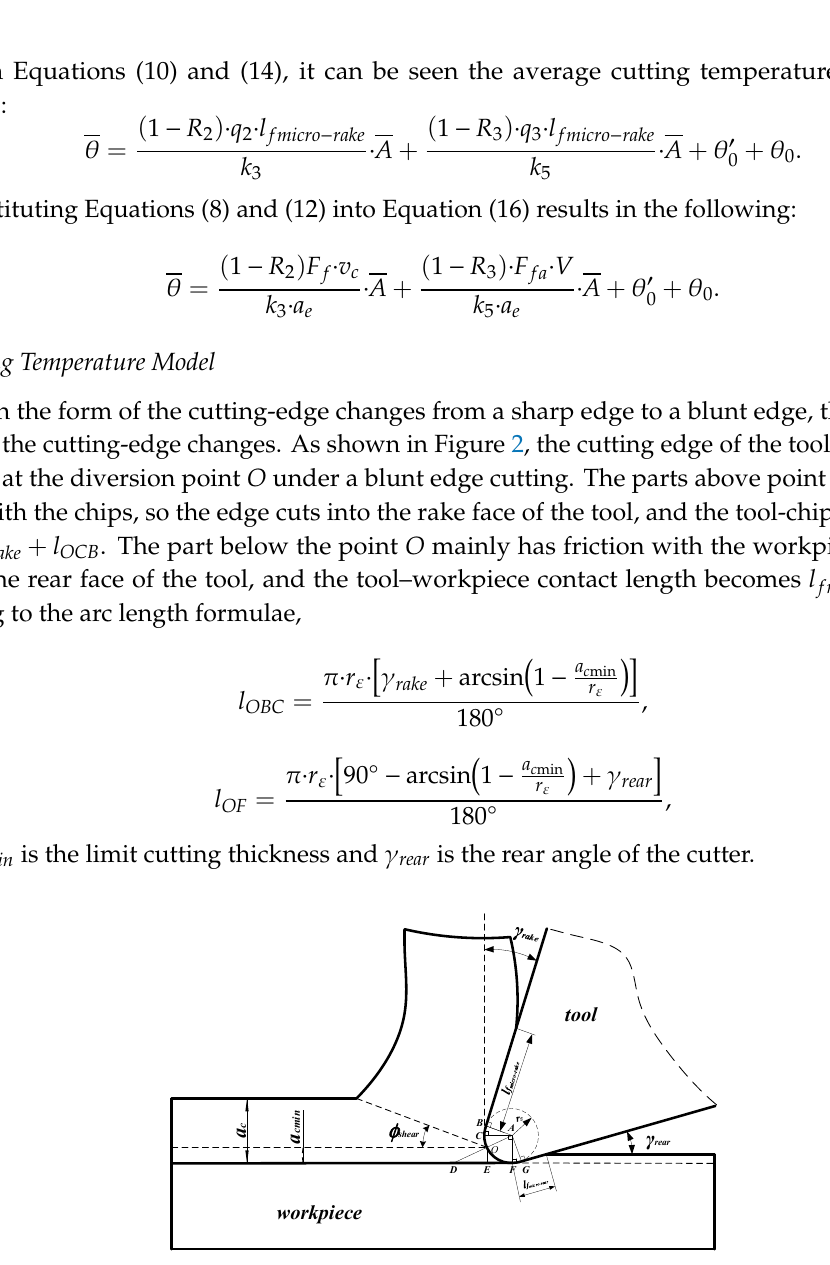
Figure 2. Milling temperature model under a blunt edge.